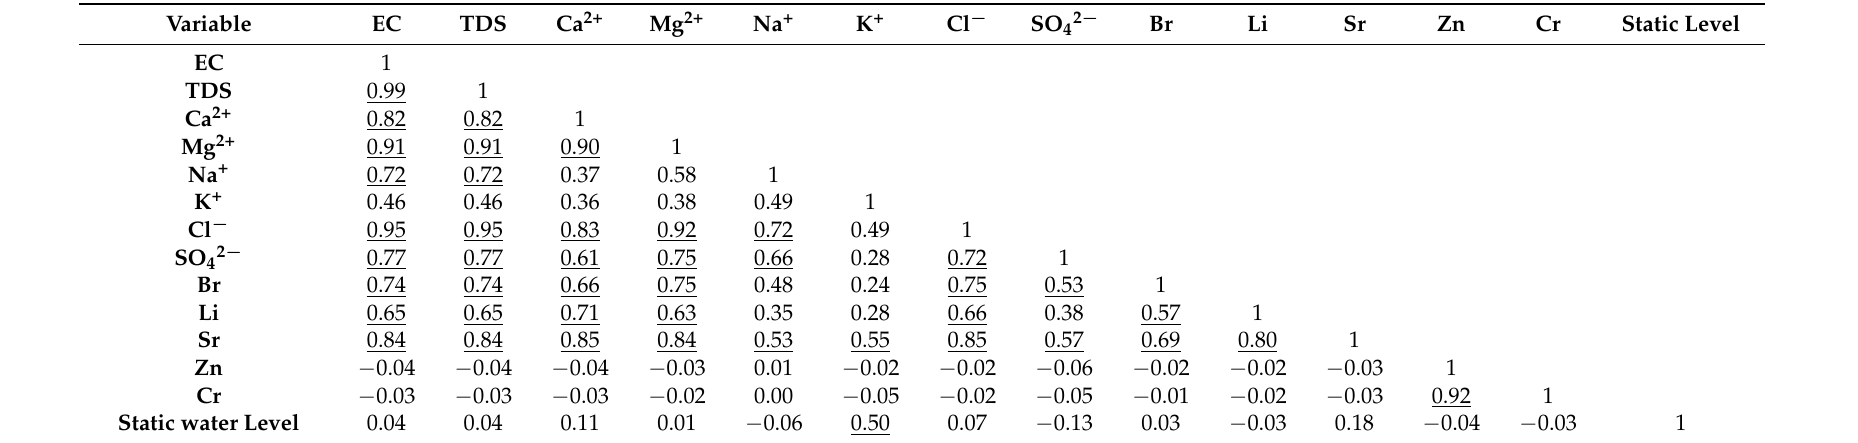
Table 2. Spearman’s rank correlation matrix for the groundwater quality